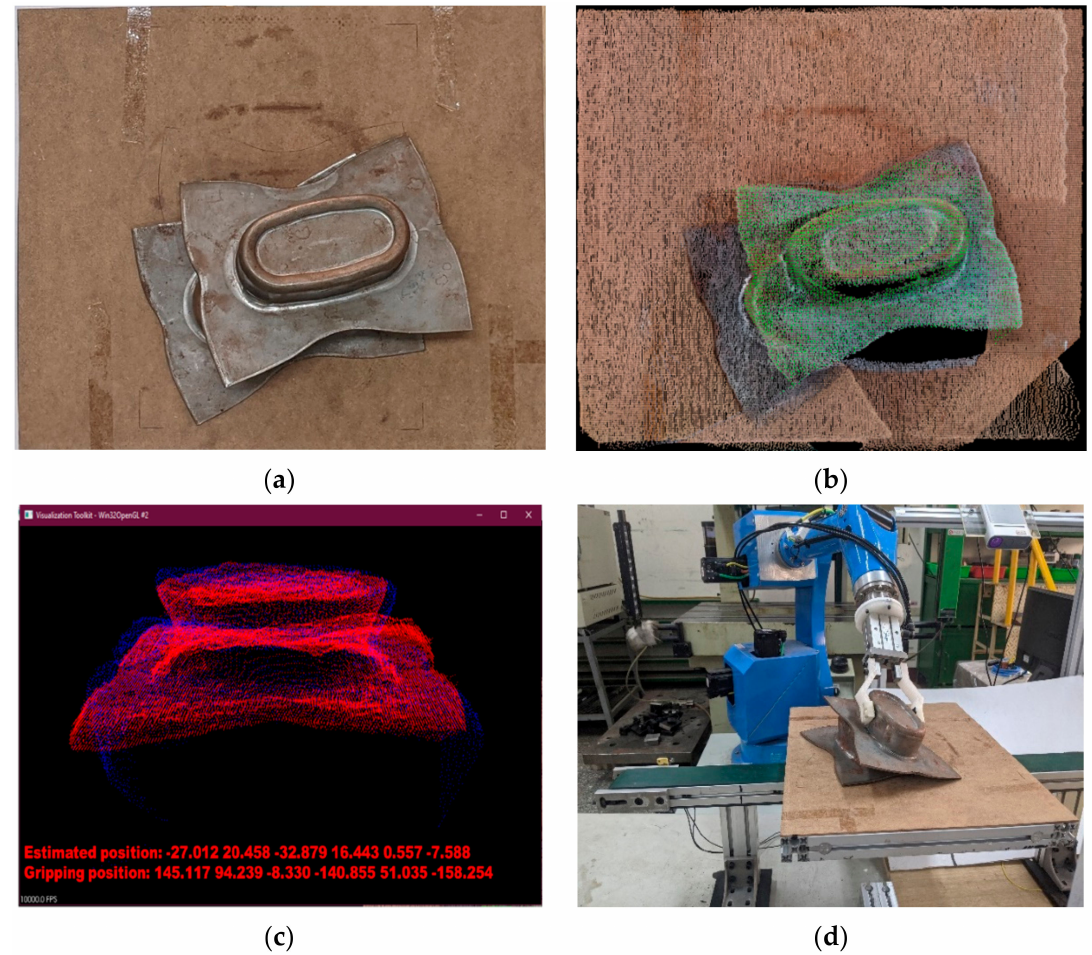
Figure 19. Dynamic piled workpieces on the conveyor ( a ) in a random position, ( b ) automatically identifying the RGB point cloud scene of a top object, ( c ) estimating the object 6-DoF poses of a top object only, and ( d ) robot grasping the top object in the dynamic